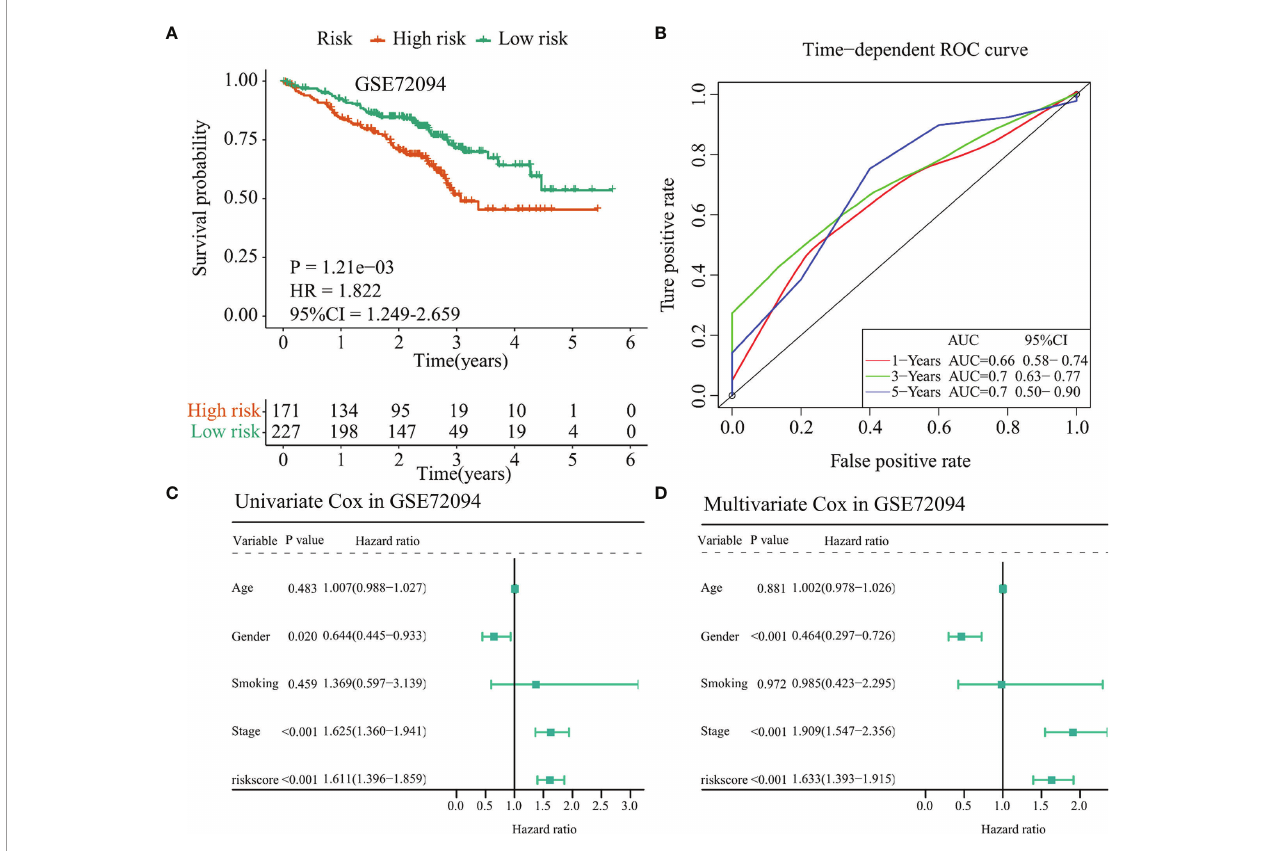
FIGURE 7 | Validation of the TCGA-LUAD signature in the GSE72094 dataset. (A) Kaplan – Meier curve presented the survival difference between the high-risk group and the low-risk group. (B) Time-dependent ROC curves at 1 year, 3 years, and 5 years. (C) Univariate Cox regression analysis regarding the risk score and other clinical parameters. (D) Multivariate Cox regression analysis about the risk score and else clinical parameters. TCGA, The Cancer Genome Atlas; LUAD, lung